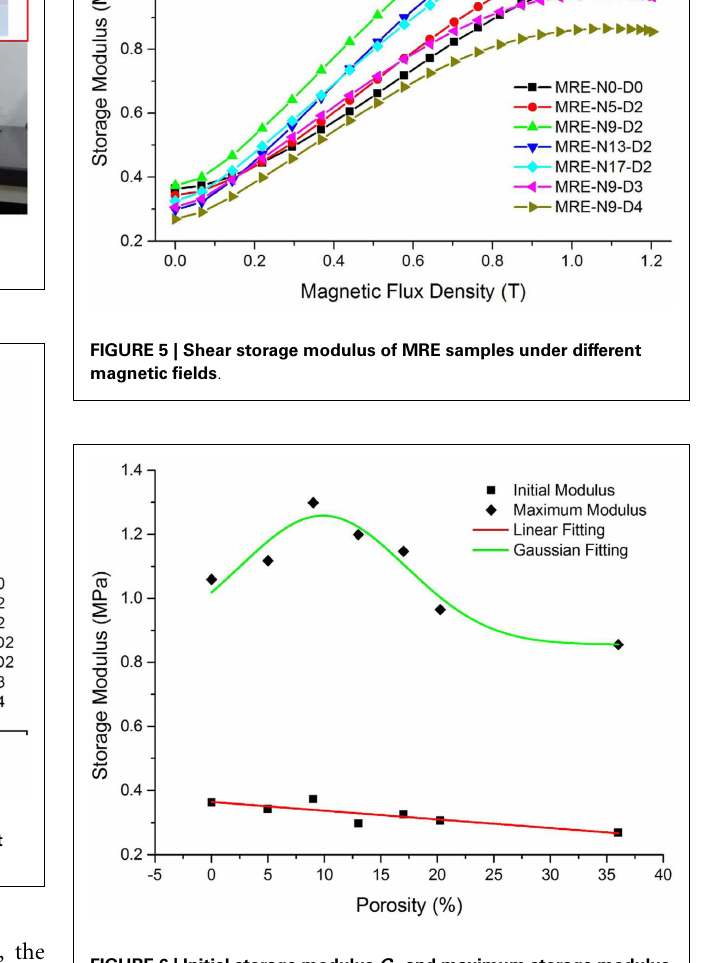
FIGURE 6 | Initial storage modulus G 0 and maximum storage modulus G _ max (cid:48) f or different porosities